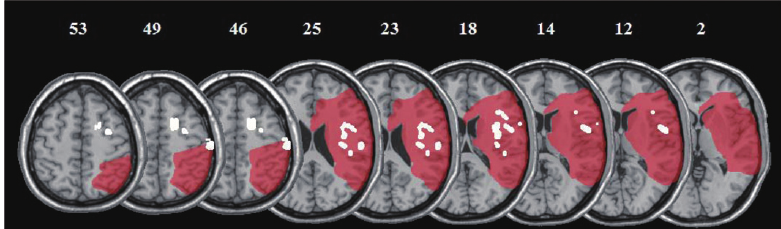
Fig. 3. In red, the lesion of CT, the patient showing also an extensive cortical damage, mapped in the stereotactic space and superimposed on brain regions (in white) involved in AHP [24]. In spite of the large cortical lesion, it is clear the sparing of some of the brain areas associated with AHP by Berti et al.